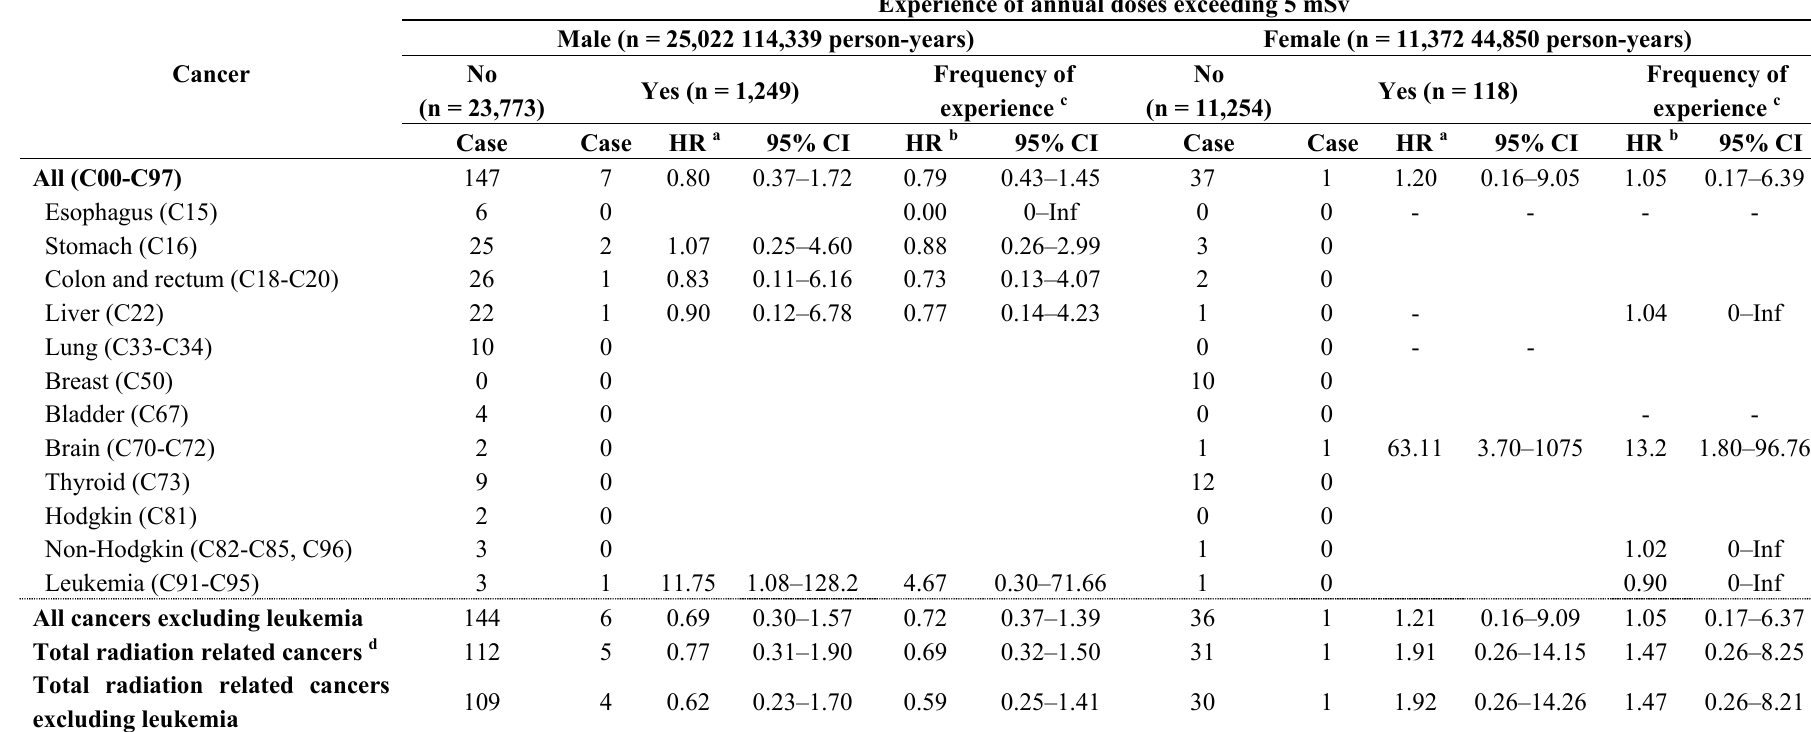
Table 4. Hazard ratio and 95% confidence intervals of cancer for experience exposed to more than 5 mSv of annual radiation dose in diagnostic radiation workers, Korea,